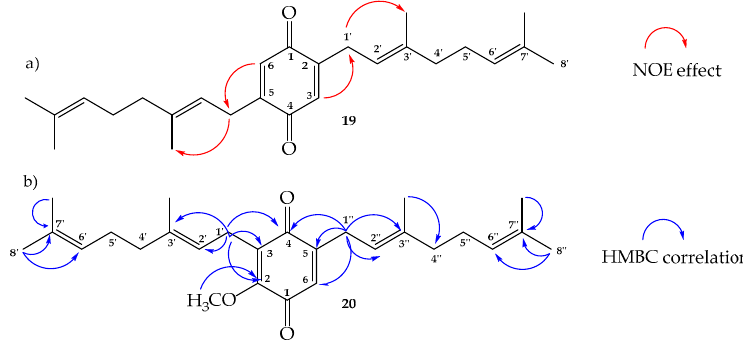
Figure 5. Main observed correlations: 1D NOE Compound 19 ( a ), 2D HMBC Compound 20 ( b ).